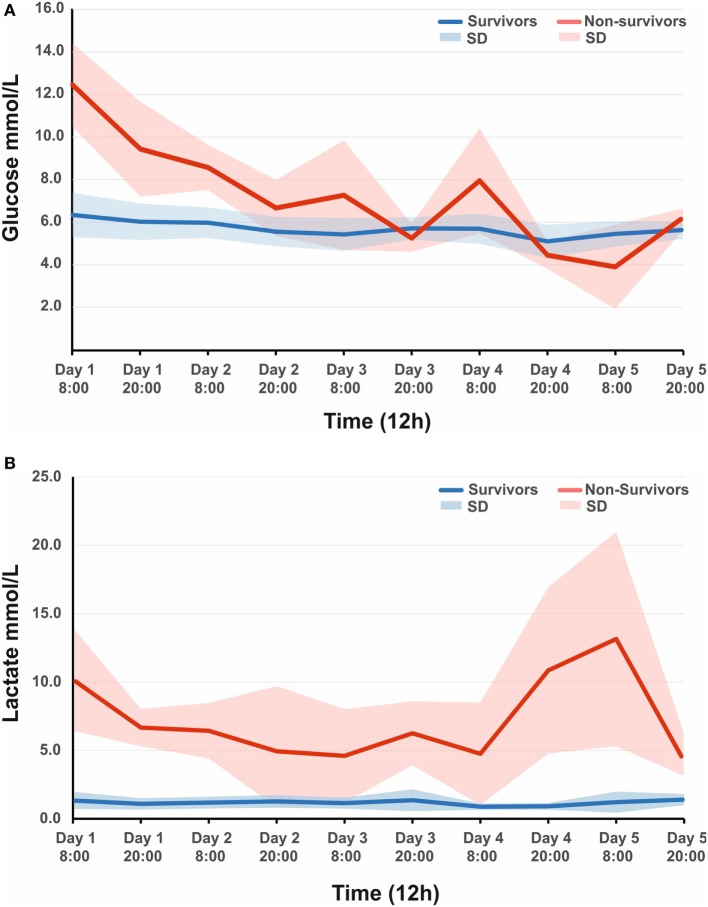
(A) Observed mean arterial glucose (SD) in pediatric traumatic brain injury (TBI) patients during the first 5 days since ictus, stratified by fatal outcome. (B) Observed mean arterial lactate (SD) in pediatric TBI patients during the first 5 days since ictus, stratified by fatal outcome.